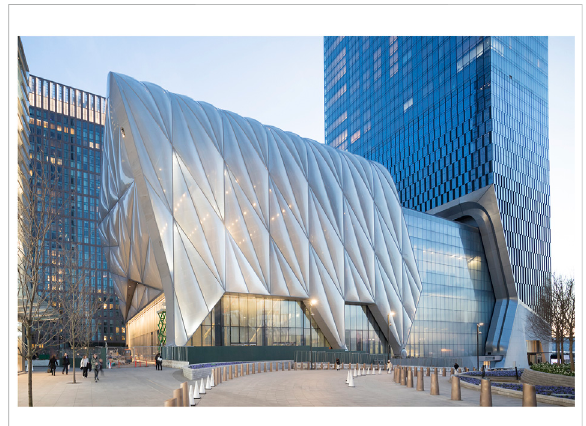
FIGURE 4 The Shed at Hudson Yards; Photography: Iwan Baan, reprinted with permission of The Shed/Diller Sco fi dio + Renfro.